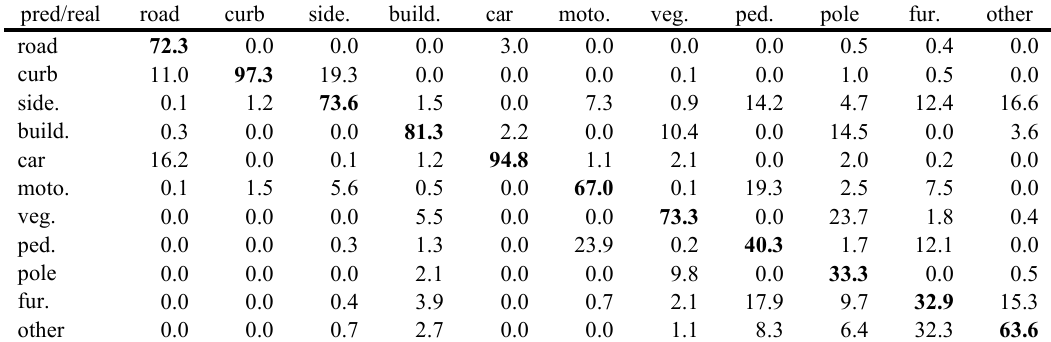
Table 7: Confusion matrix (% recall ) for 11 classes, 200 hidden layers and weighted. pred/real